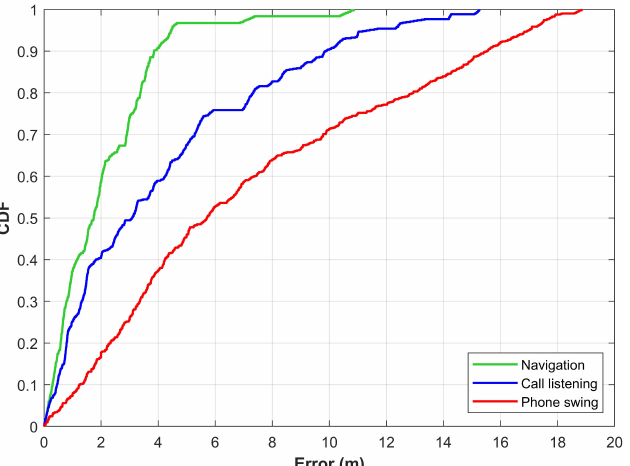
Figure 10. The CDF graphs for three orientations of the smartphone including ‘nvaigation’, ‘call listening’, and ‘phone